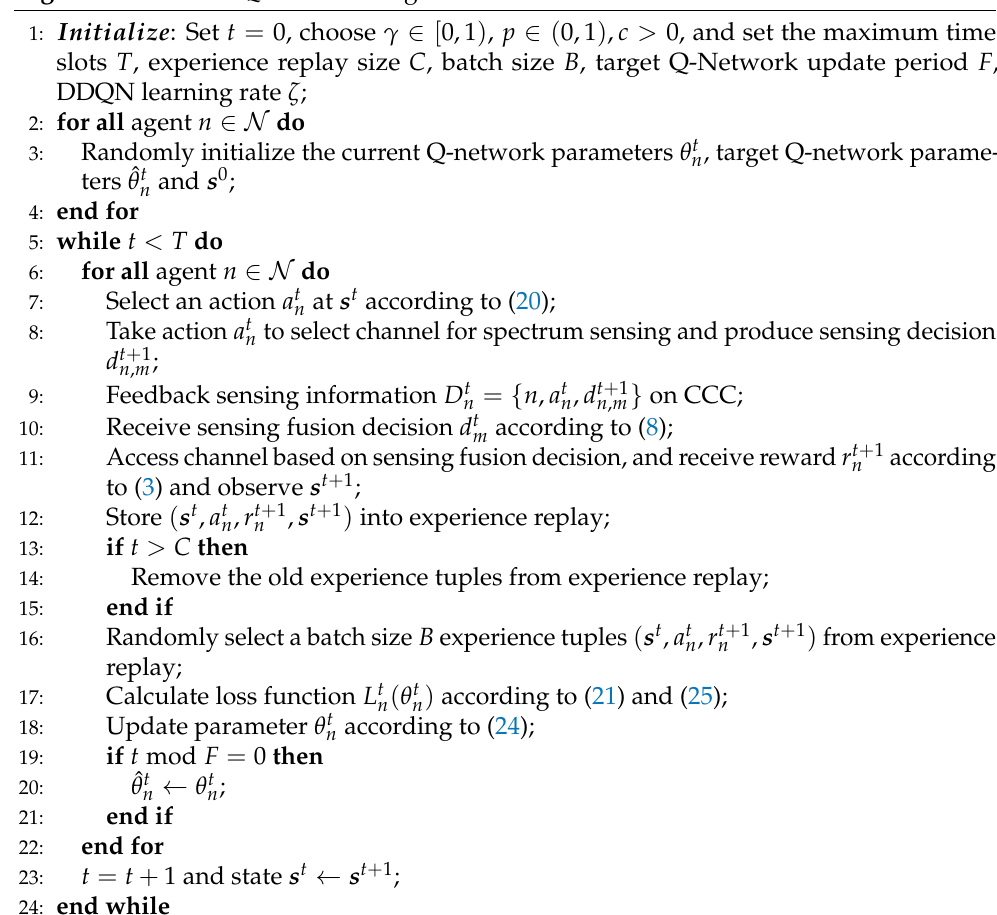
Algorithm 2 : IL-DDQN-UCB-H